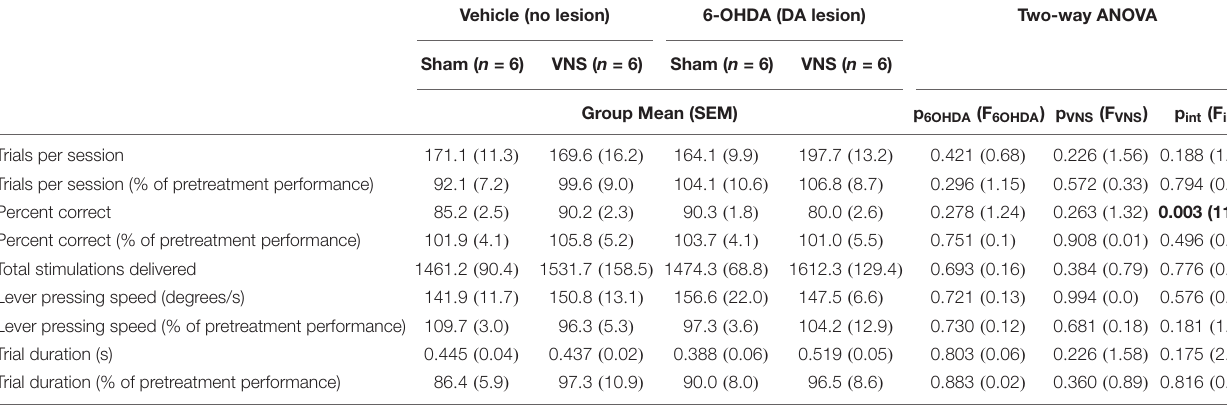
FIGURE 4 | Vagus nerve stimulation administration did not alter behavioral performance. (A) Average trials per session did not differ across treatment groups during recovery (R, squares) or stimulation (S, triangles) periods, nor did any group exhibit a significant change in trials performed during VNS or sham stimulation. (B) The percentage of rewarded trials per session did not differ across groups during recovery or stimulation epochs, and no group exhibited a significant change in percent correct performance during stimulation sessions. (C) Total VNS or sham stimulations delivered, which is identical to the total number of rewarded trials during the final 10 training sessions, did not differ across groups. Legend for all panels is shown in (A) . TABLE 3 | Behavioral performance during the stimulation period did not differ across treatment groups. Vehicle (no lesion) 6-OHDA (DA